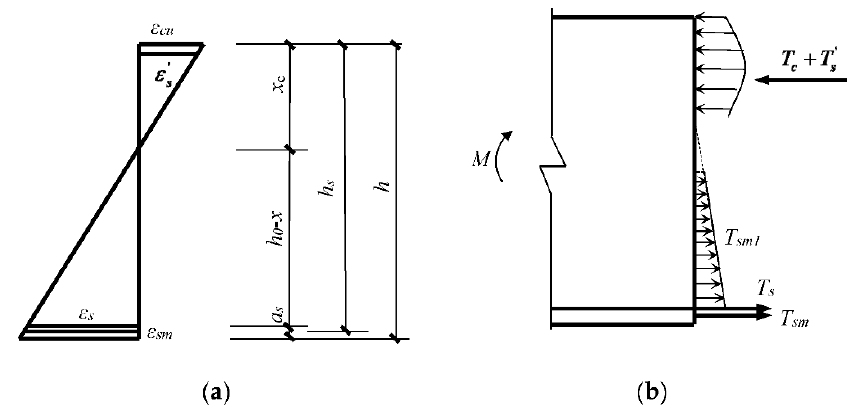
Figure 17. Cross-sectional stress and strain distributions of the component. ( a ) Cross-sectional strain distribution; ( b ) cross-sectional stress distribution.